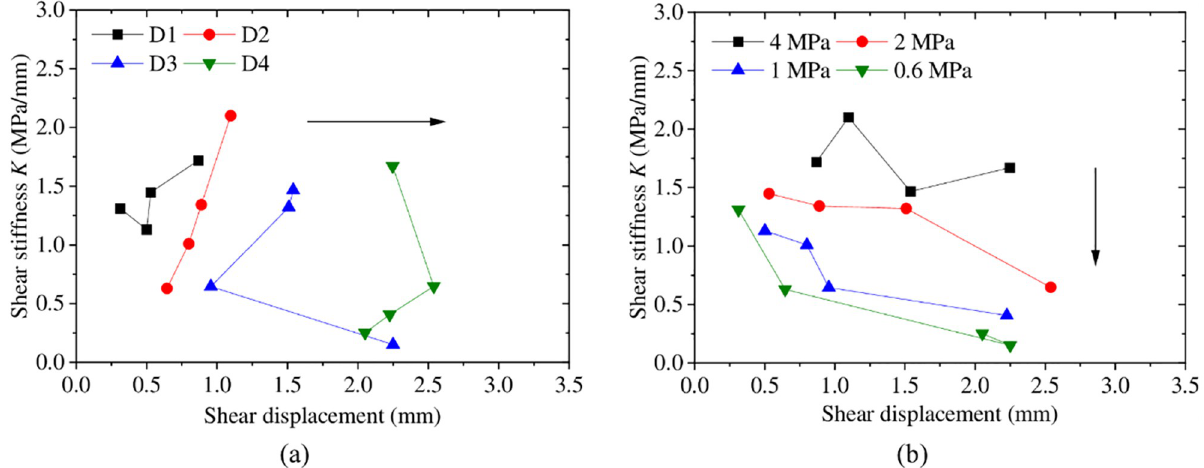
Fig 10. Plot of shear stiffness versus shear displacement (a) with different surface morphologies; (b) with different normal